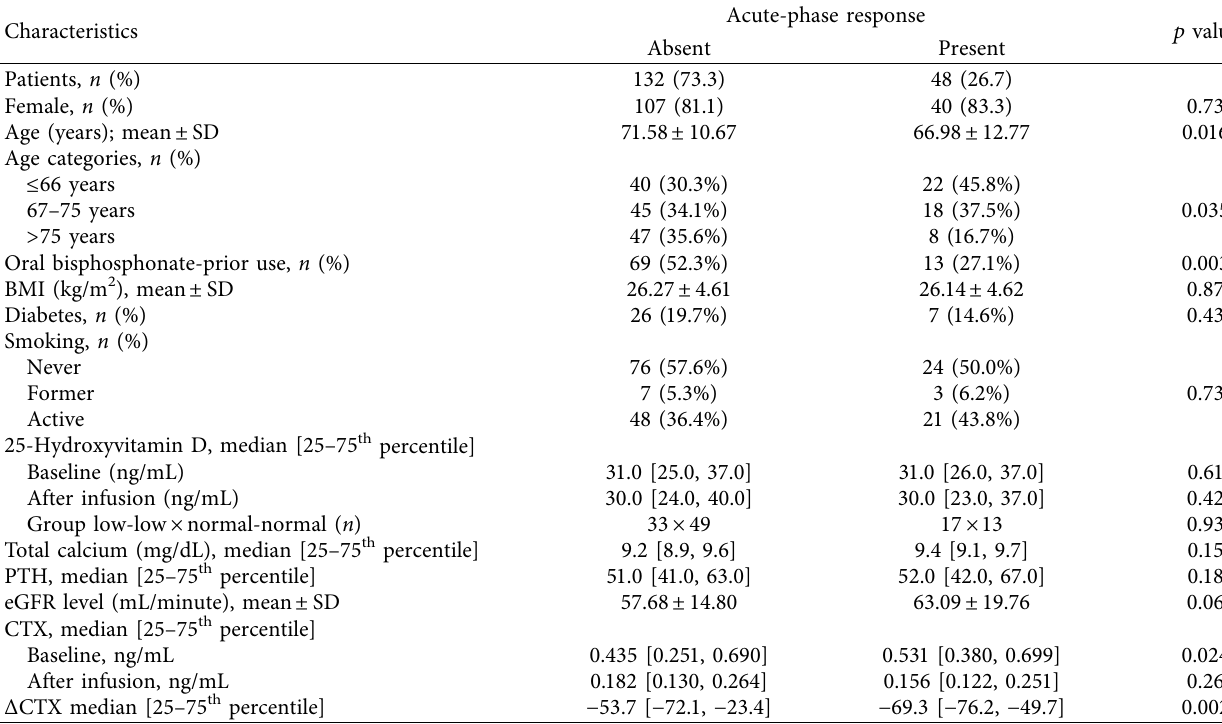
Table 4: Demographic and clinical characteristics of 180 patients with data on CTX according to the presence or absence of acute-phase response following zoledronic acid